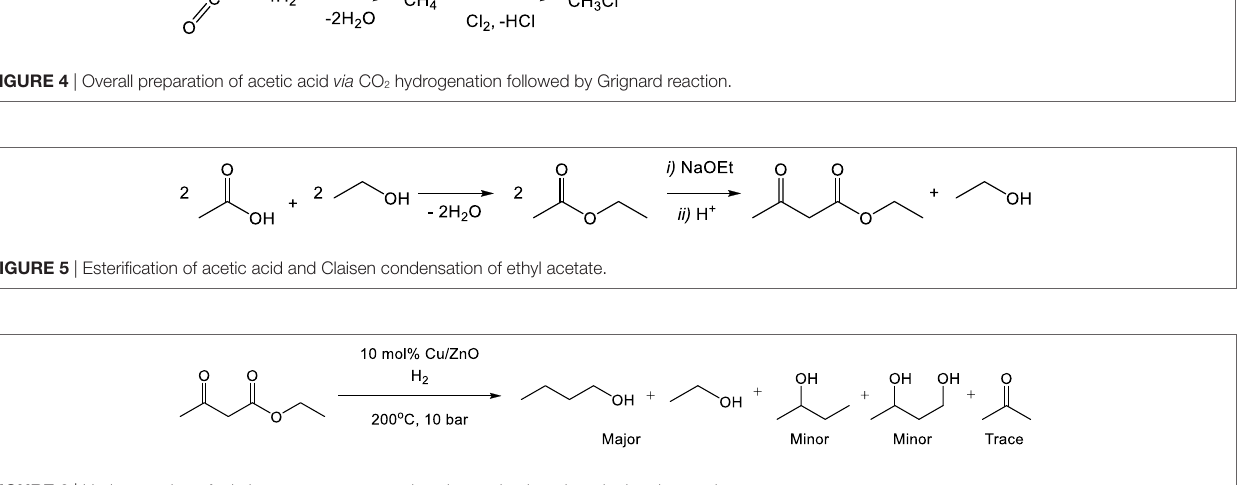
FigUre 6 | Hydrogenation of ethyl acetoacetate to produce butanol, ethanol, and minor